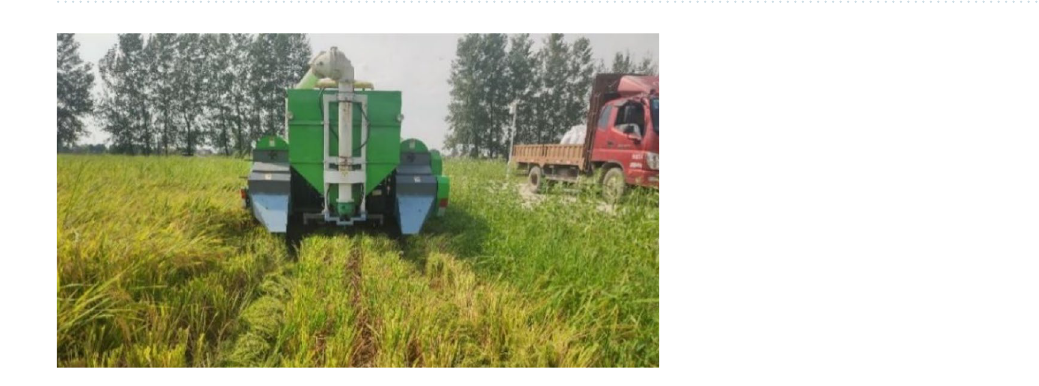
Figure 7. Bench test of smashed straw scattering. ( A ) simulation of rolling and stubble area, ( B ) feeding inlet.